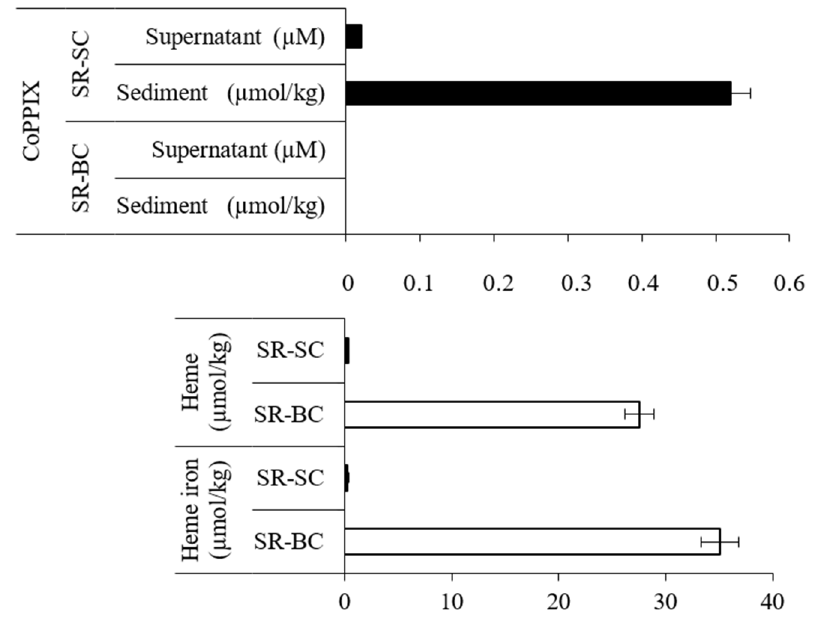
Figure 3. Concentration of CoPPIX, heme and heme iron in SR-BC and SR-SC (µmol/kg of sediment or µM (supernatant)). Selected ion ( m / z 621) gas chromatogram of CoPPIX and calibration curve for determining the concentration of CoPPIX are presented in Figures S1 and S2, respectively. HPLC-PAD chromatogram of heme is presented in Figure S3A. AED chromatogram of heme is presented in Figure S5. Calibration curves for determining the concentration of heme and heme iron are presented in Figures S4 and S6, respectively. All presented differences are statistically significant (significance level: p < 0.05). Supplementary results of chemical analyses of SR-BC and SR-SC are presented in Figures S13–S22 and Table S2.